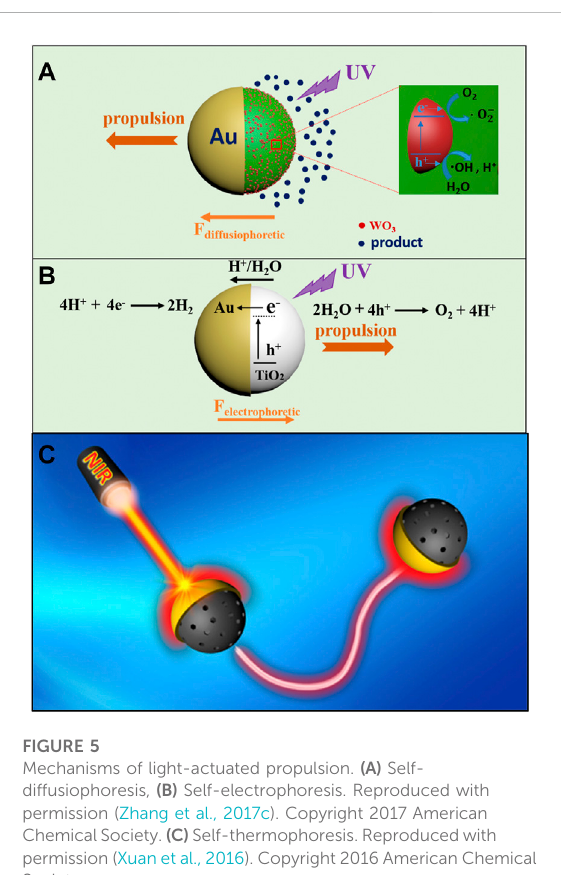
FIGURE 5 Mechanisms of light-actuated propulsion. (A) Self- diffusiophoresis, (B) Self-electrophoresis. Reproduced with permission (Zhang et al., 2017c). Copyright 2017 American Chemical Society. (C) Self-thermophoresis. Reproducedwith permission (Xuan et al., 2016). Copyright 2016 American Chemical